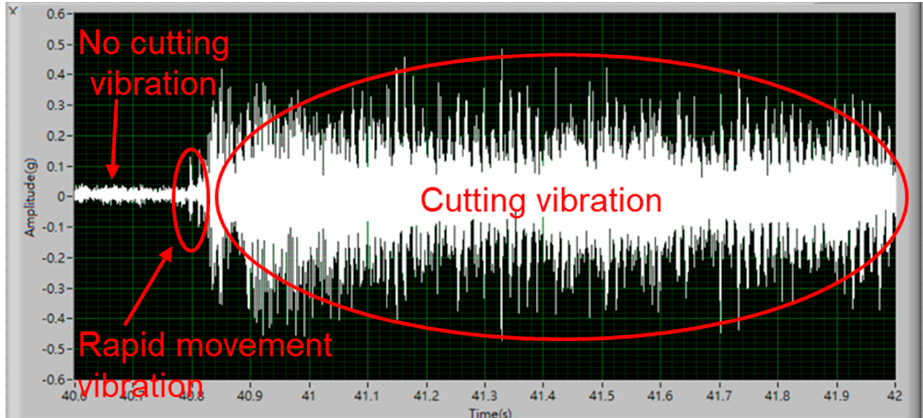
Figure 7. Original vibration signal in time domain.